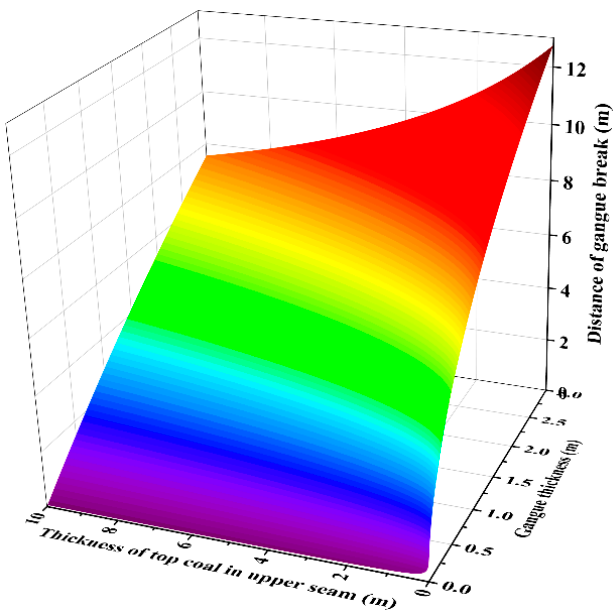
Figure 7. Three-dimensional distribution relationship between the breaking interval and thickness of the gangue layer and the thickness of the top coal of the upper stratum. The average thickness of the top coal seam 4-1 in the upper part of the gangue layer is 1.5 m, as shown in Figure 7. The thickness of the high-level gangue layer is 0.2~2.0 m, and the breaking interval of the gangue layer under the uniform load is 1.4~8.7 m The top coal thickness of the gangue layer is 0 < l < 1.5 m (high-level gangue layer), and the gangue l breaking interval with the thickness of the gangue h p changes more sharply. When 1.5 m < h m < 10 m, the three-dimensional distribution relationship surface is relatively flat, that is, the gangue-breaking interval with the gangue thickness changes more smoothly. The effect of the change in the thickness of the gangue is not significant. It can be concluded that the high-level gangue layer is more sensitive to the change of the thickness of the gangue layer. Similarly, when the thickness of the interlayer 0 < h p < 1 m, l varies significantly only in the h m < 1.5 m range. When the gangue thickness 1 < h p < 3 m, in the range of 0 < h m < 10 m, there are more moderate and uniform changes. This demonstrates that while the gangue thickness is thin, the high-level gangue layer has a more obvious influence on l . When the gangue layer thickness is thicker, the effect of layer level change on l becomes less obvious, but l still gradually becomes larger with the increase of gangue layer level. Based on the above analysis, and combined with the occurrence conditions of the gangue layer in working face 42,108, the gangue layer between the 4-2 and 4-1 coal seams has a thickness of 0.8–1.5 m in the range of 870–1360 m of the working face, and the gangue layer has a high level of thickness, which bears a great negative impact on the top coal